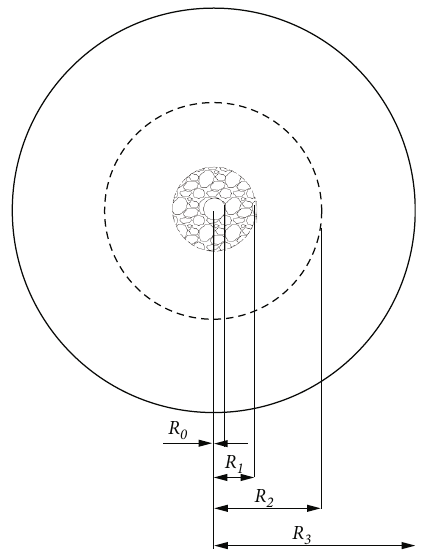
Figure 12: Internal e ff ect of blasting.